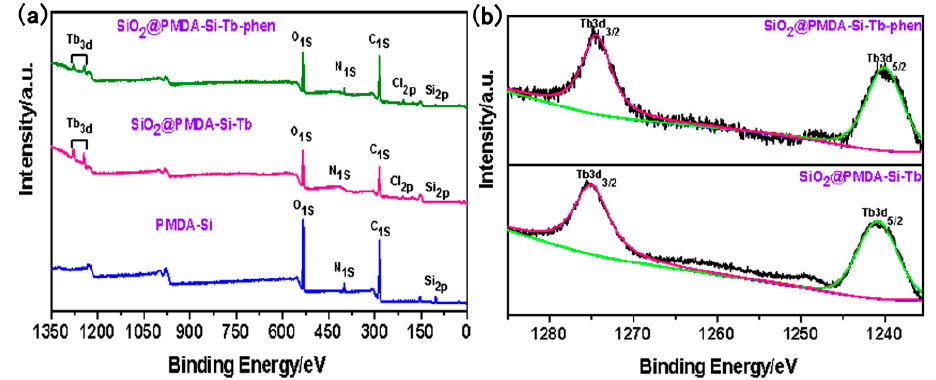
Figure 5. X-ray photoelectron spectroscopic (XPS) analysis of the PMDA-Si, SiO 2 @PMDA-Si-Tb and SiO 2 @PMDA-Si-Tb-phen samples: XPS full spectra ( a ) and XPS Tb3d spectra ( b ).